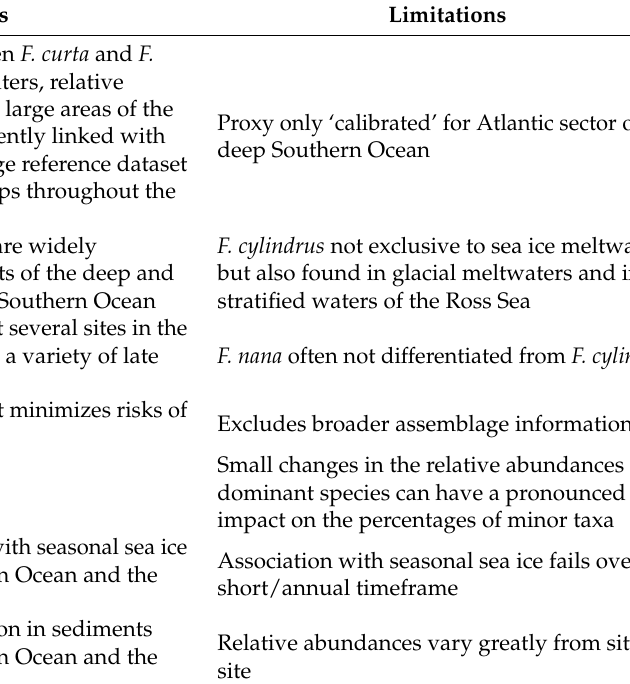
Table 8. Summary of main advantages and limitations of the eight proxy